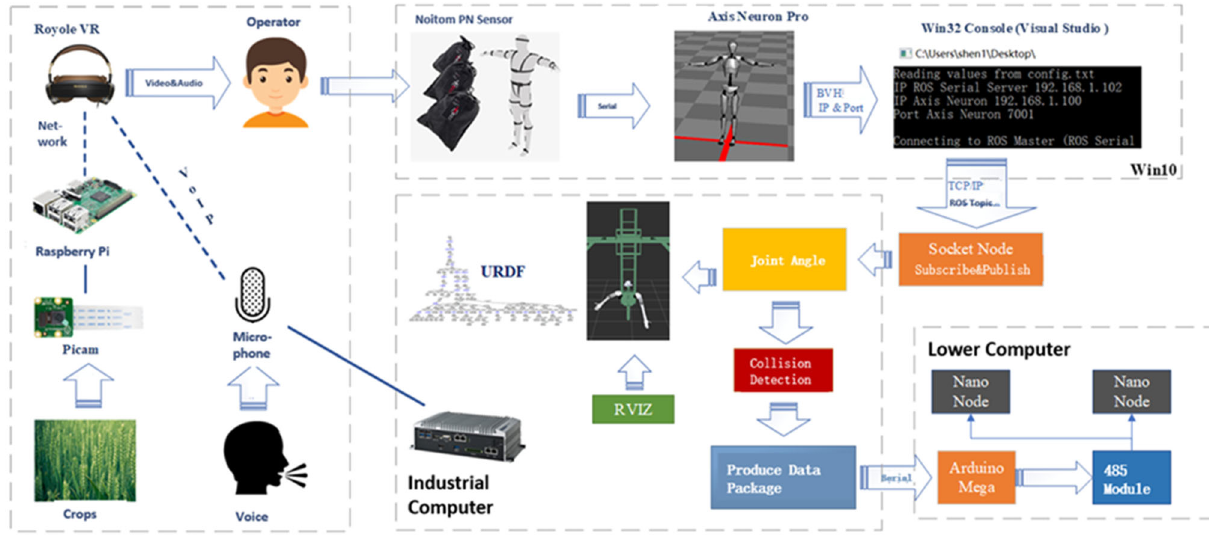
Figure 3. Human–robot interactive (HRI) framework for interactive phenotyping.